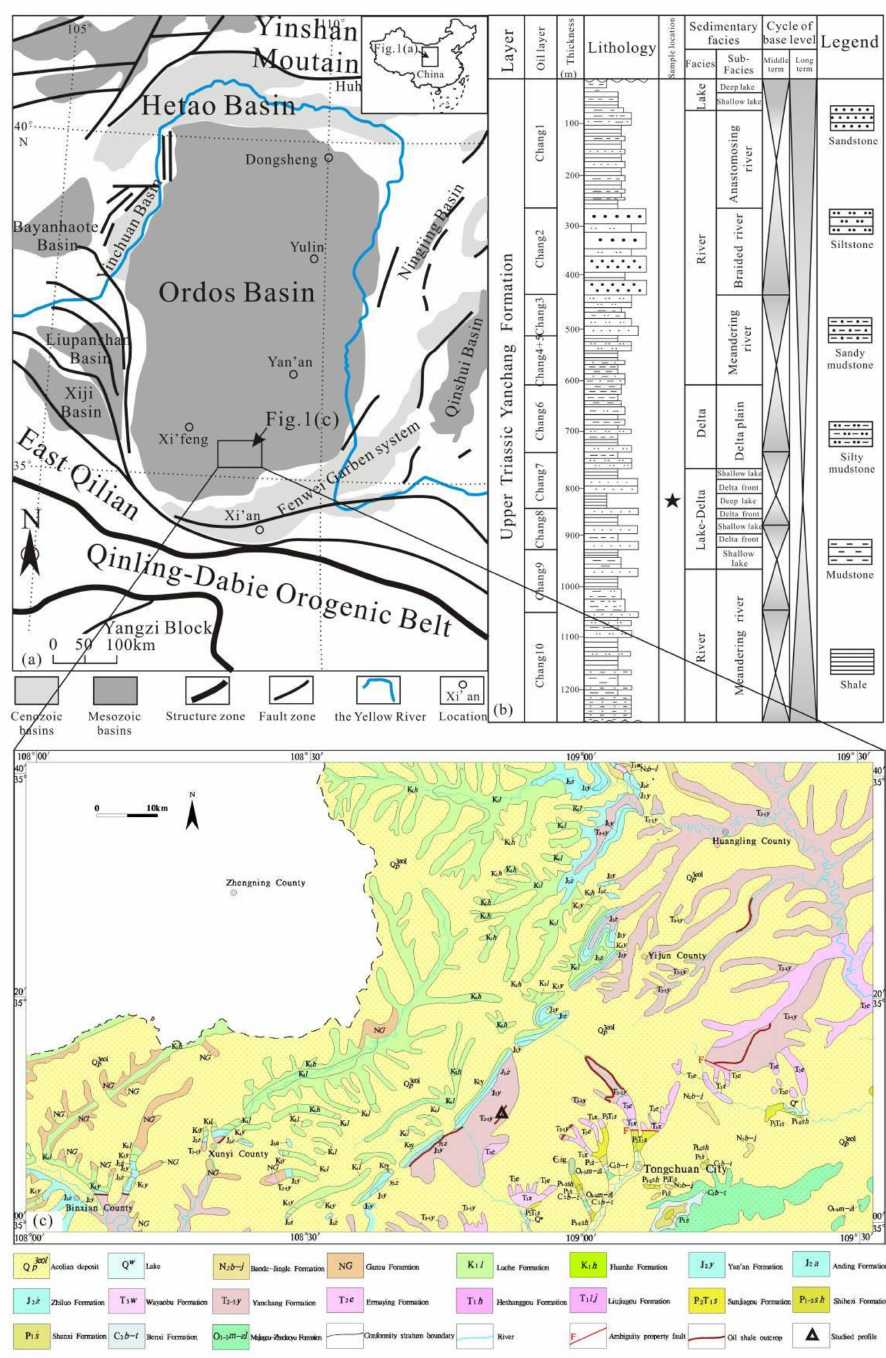
Figure 1. ( a ) Tectonic sketch map of Ordos Basin and adjacent areas (modified after Wang et al. [21]). ( b ) Stratigraphic column of Upper Triassic Yanchang Formation (modified after Li et al. [4]). ( c ) Simplified geological map of southern Ordos Basin (modified after Ma et al. [18] and Li et al.